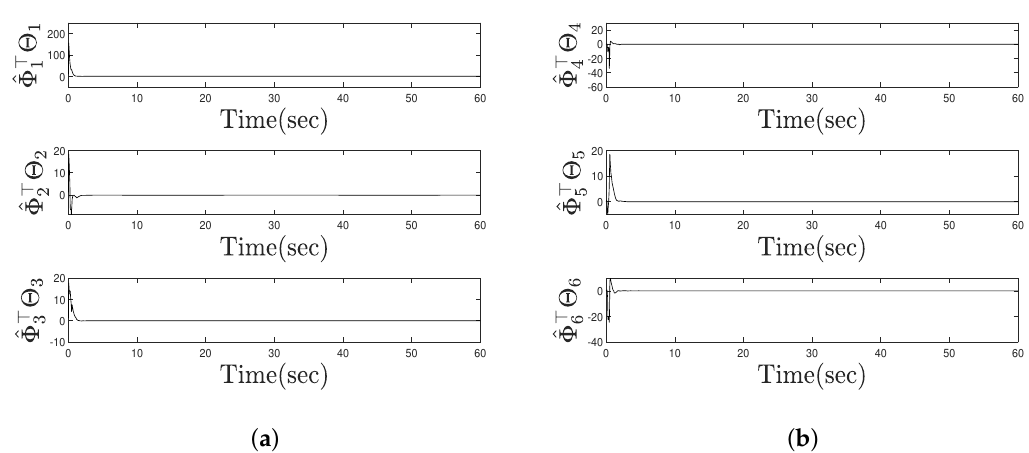
Figure 12. Outputs of radial basis function neural networks for Scenario 2 ( a ) Φ 1 Θ 1 , Φ 2 Θ 2 , and Φ 3 Θ 3 ( b ) Φ 4 Θ 4 , Φ 5 Θ 5 , and Φ 6 Θ 6 .